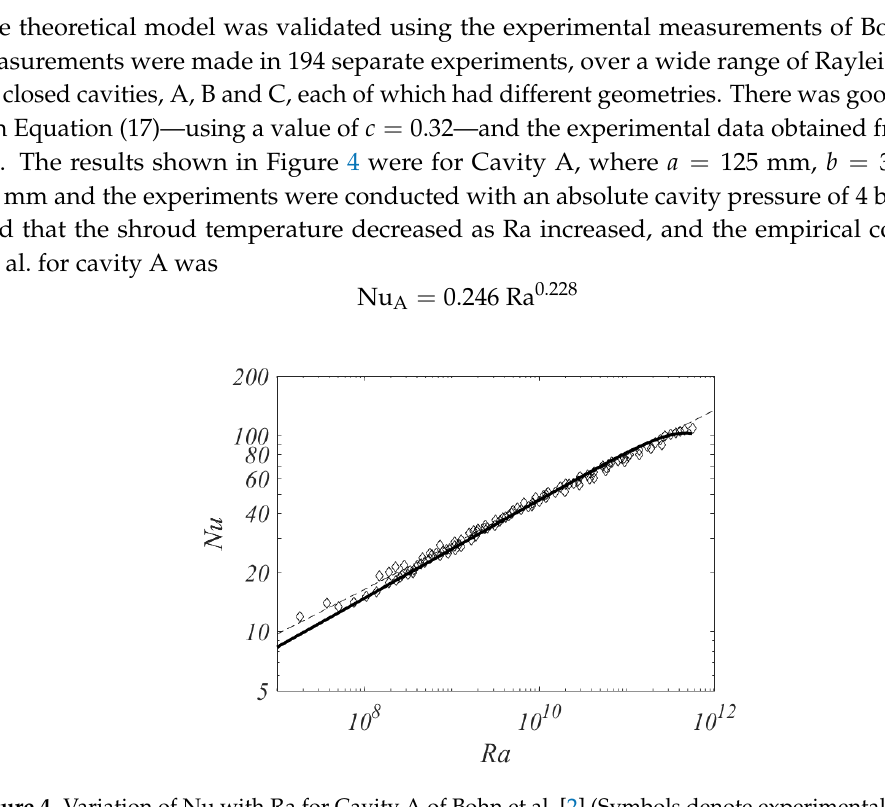
Figure 4. Variation of Nu with Ra for Cavity A of Bohn et al. [2] (Symbols denote experimental data [9]; solid curve denotes theoretical solutions; broken curve denotes empirical correlations).